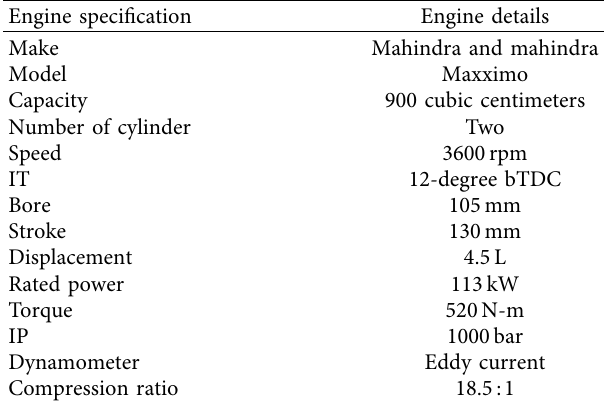
Table 3: Various alcohols fuels blends [16].